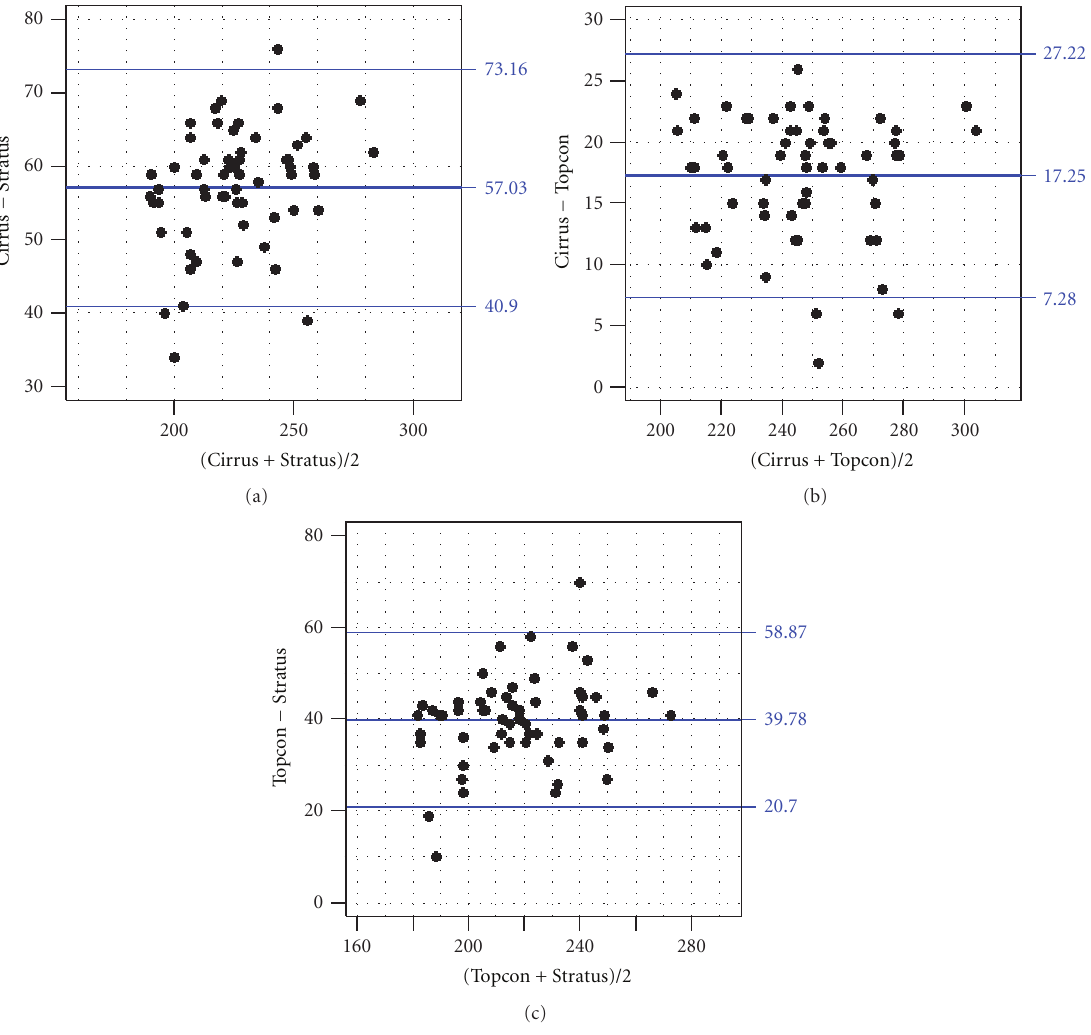
Figure 2: Bland Altman plots showing paired CMT di ff erences versus average thickness for each machine comparison. (a) Cirrus minus Stratus. (b) Cirrus minus Topcon. (c) Topcon minus